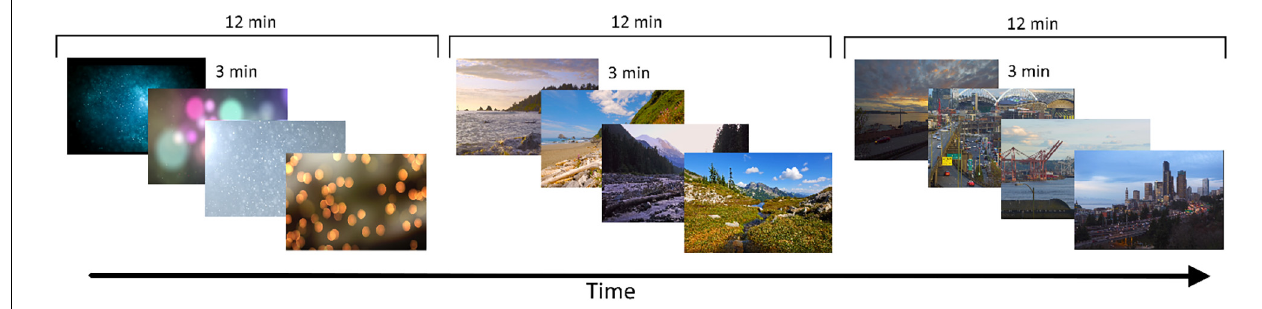
FIGURE 1 | Example of the experimental procedure. In this example, four videos of the neutral condition are followed by four videos of the nature conditions, and four videos of the urban condition concluded the experimental session. Each condition was composed of four 3-min